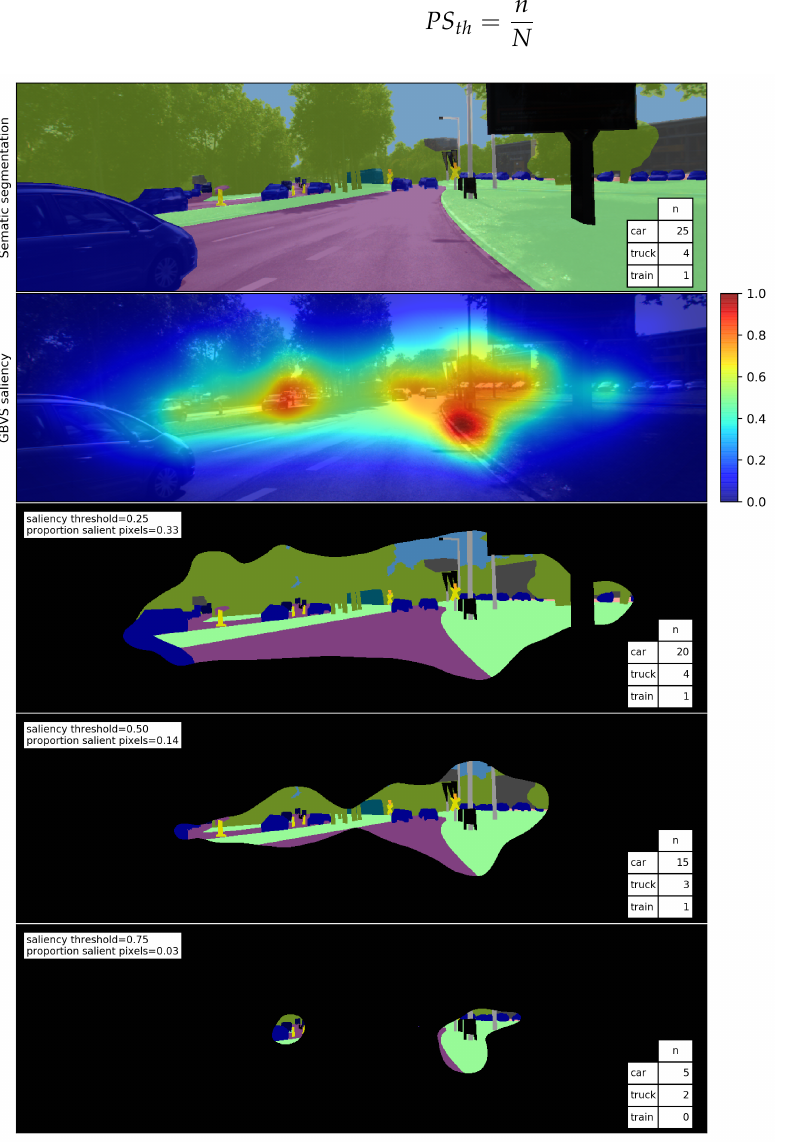
Figure 4. Example of the threshold analysis for a given segmented image. The top image shows the segmented image and the number n of object instances. Below the corresponding saliency map computed with the GBVS model is displayed. Subsequently, the proportion of salient pixels and the number of object instances in the salient area for different saliency thresholds are